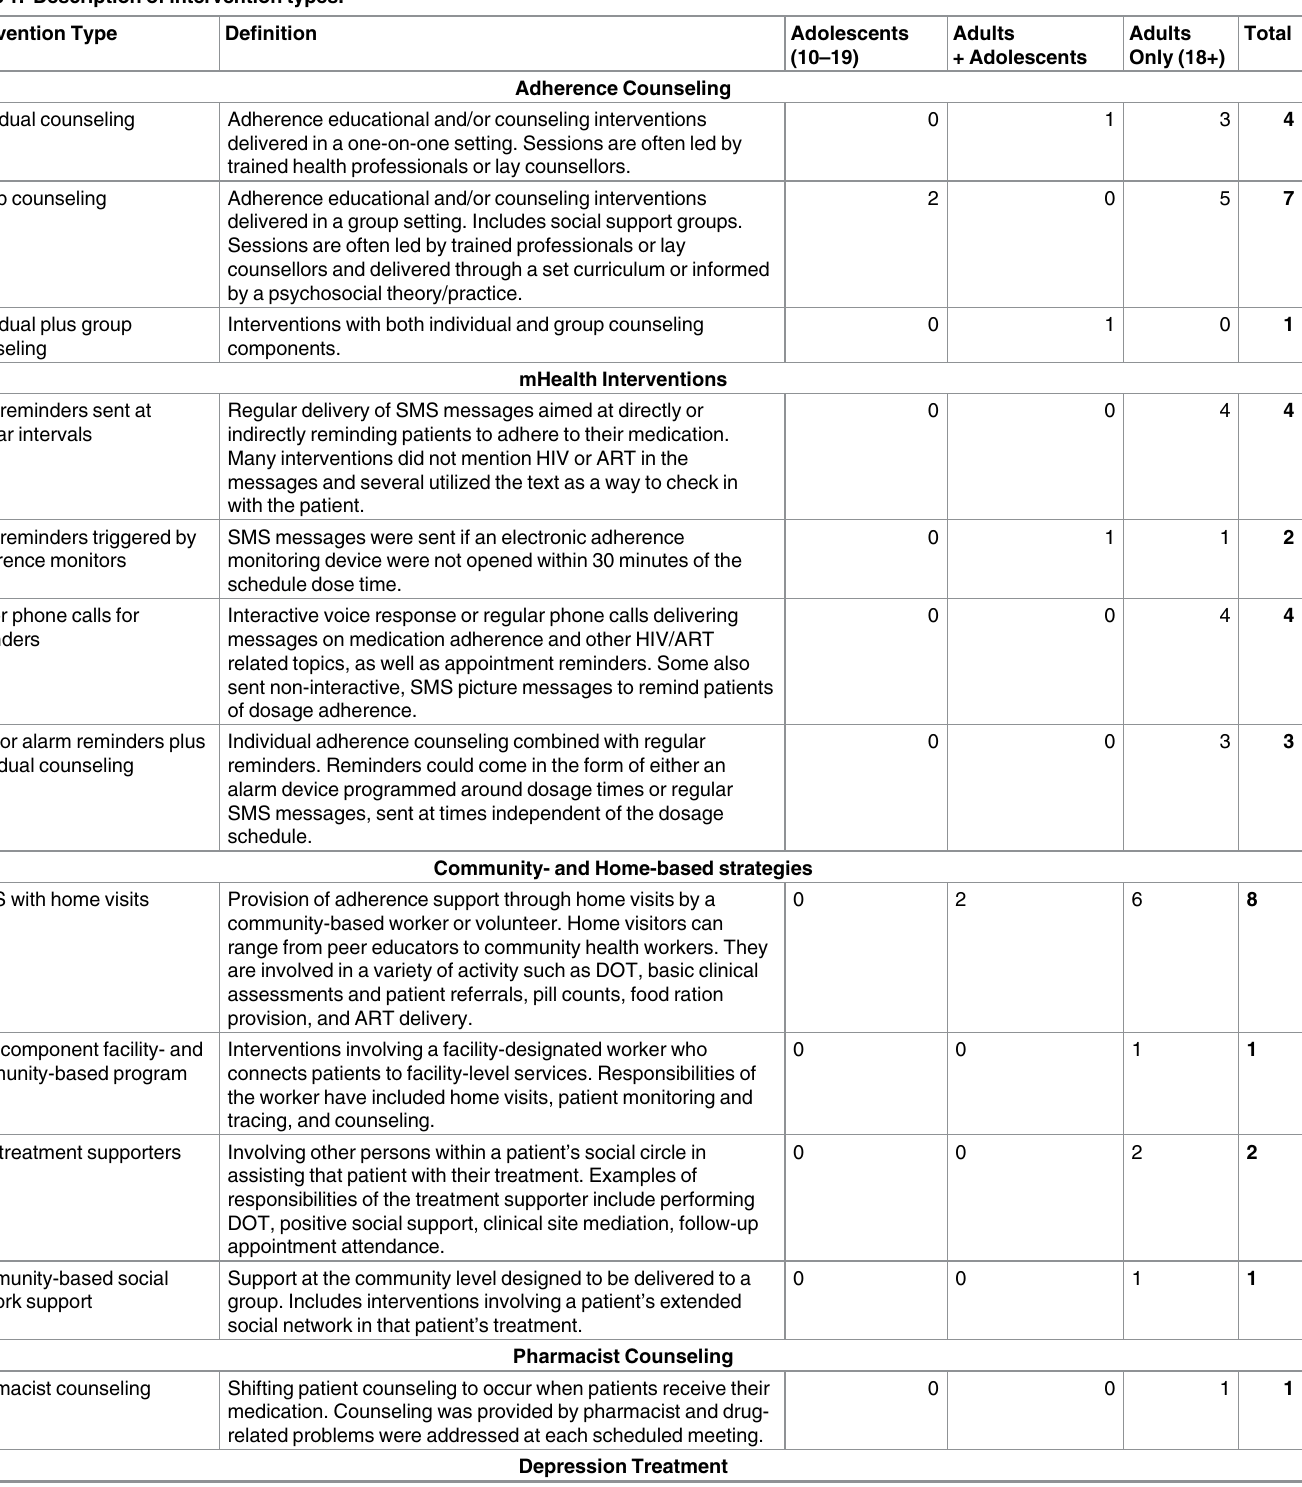
Table 1. Description of intervention